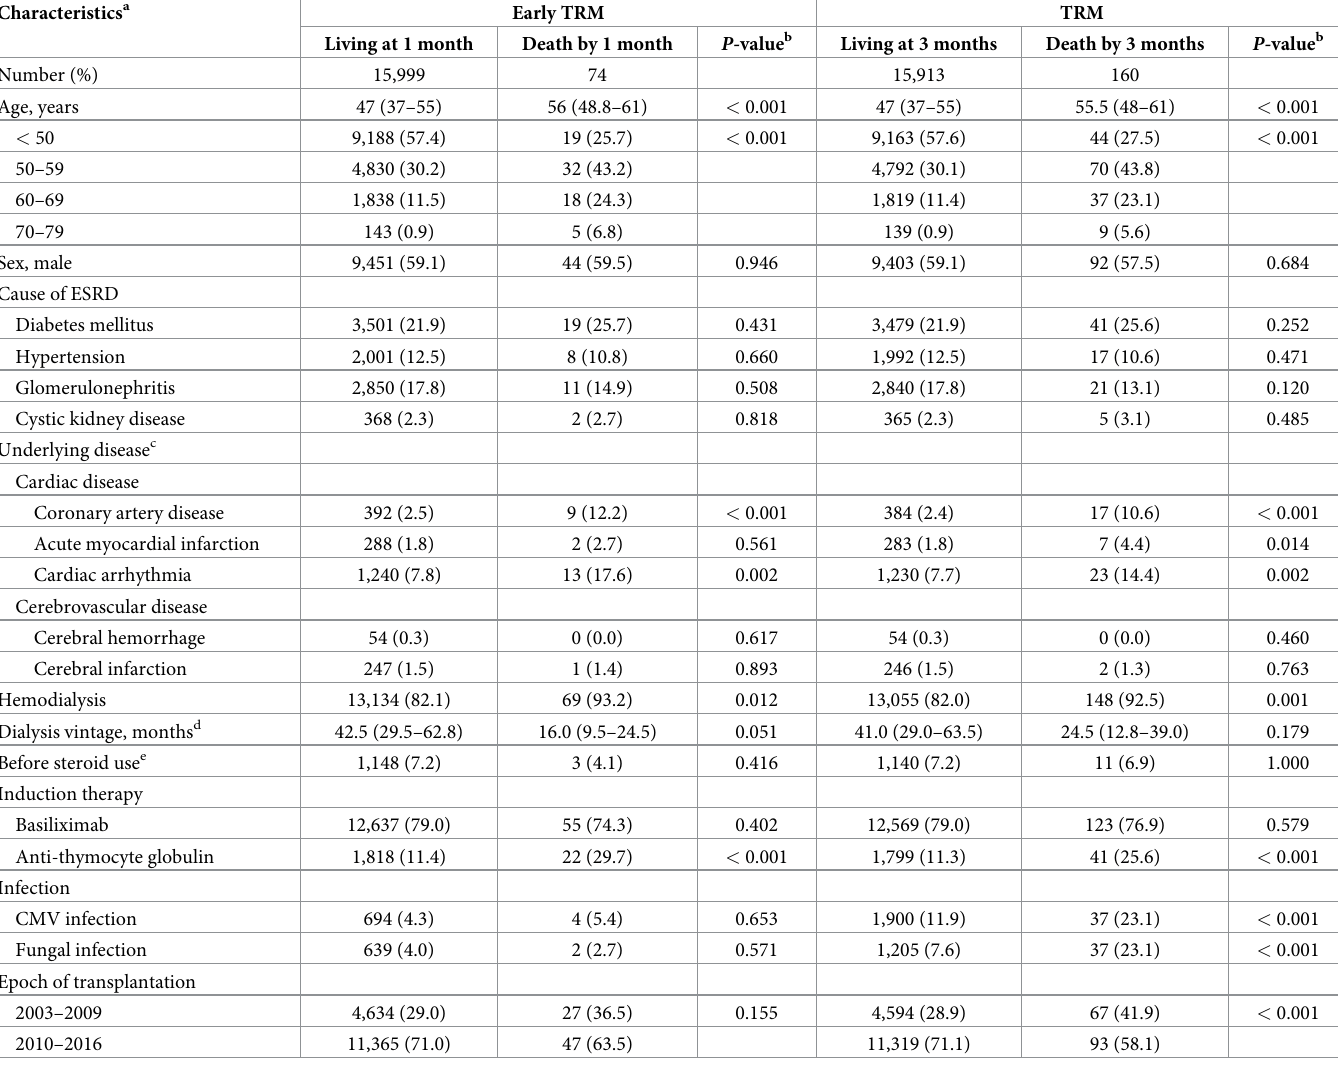
Table 1. Comparison of the characteristics between living kidney recipients versus deceased ones at 1 and 3 months after transplantation. Characteristics